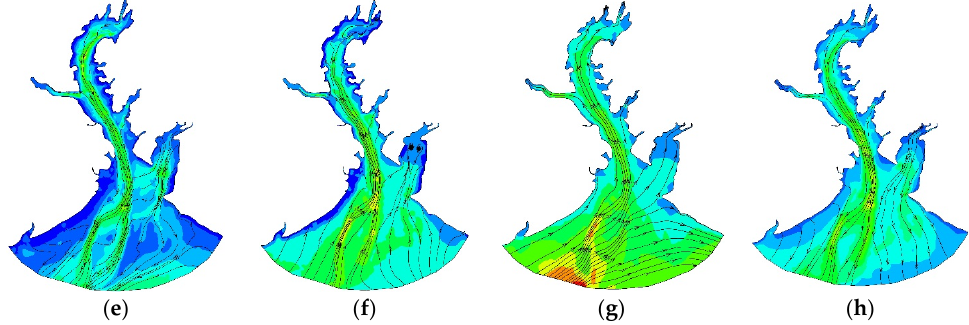
Figure 7. Map of the streamline of spring and neap tides: ( a – d ) the tidal process of spring tide (e.g., 4